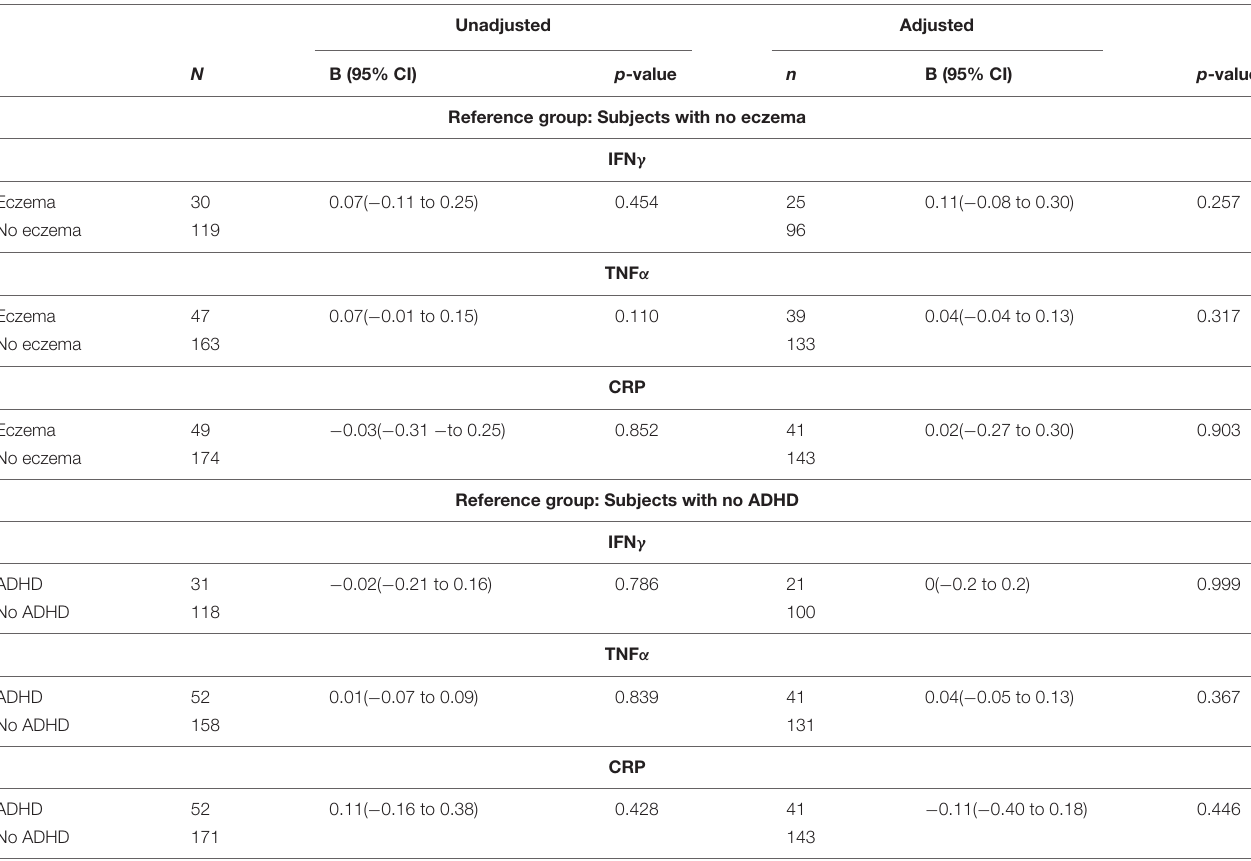
TABLE 3 | Differences in cord blood cytokines.